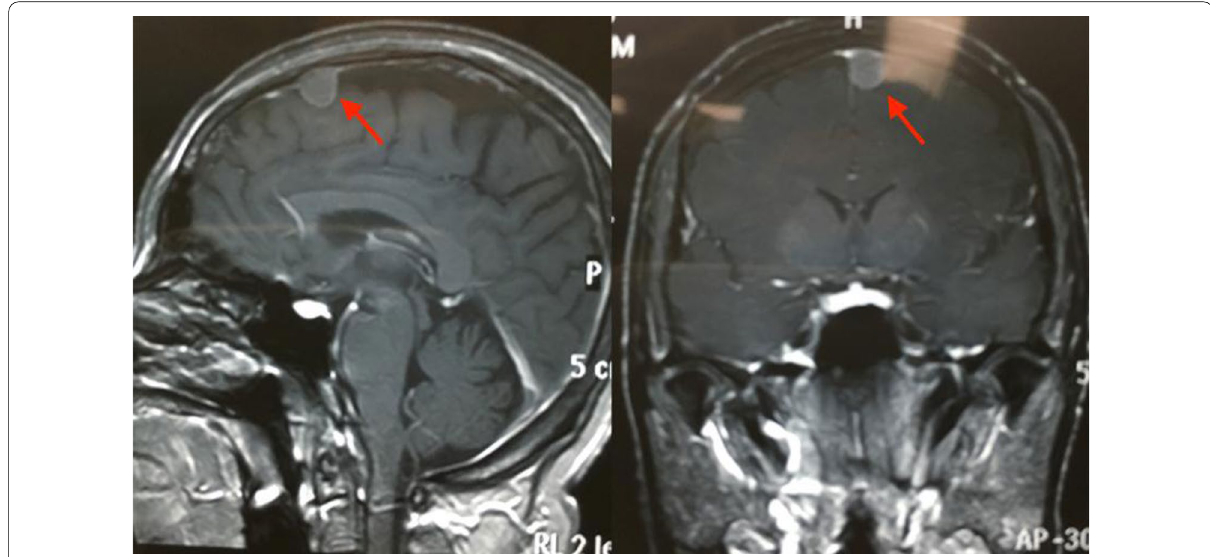
Fig. 1 After admission, MRI showed that the tumor has invaded the sagittal sinus (as the red arrows point